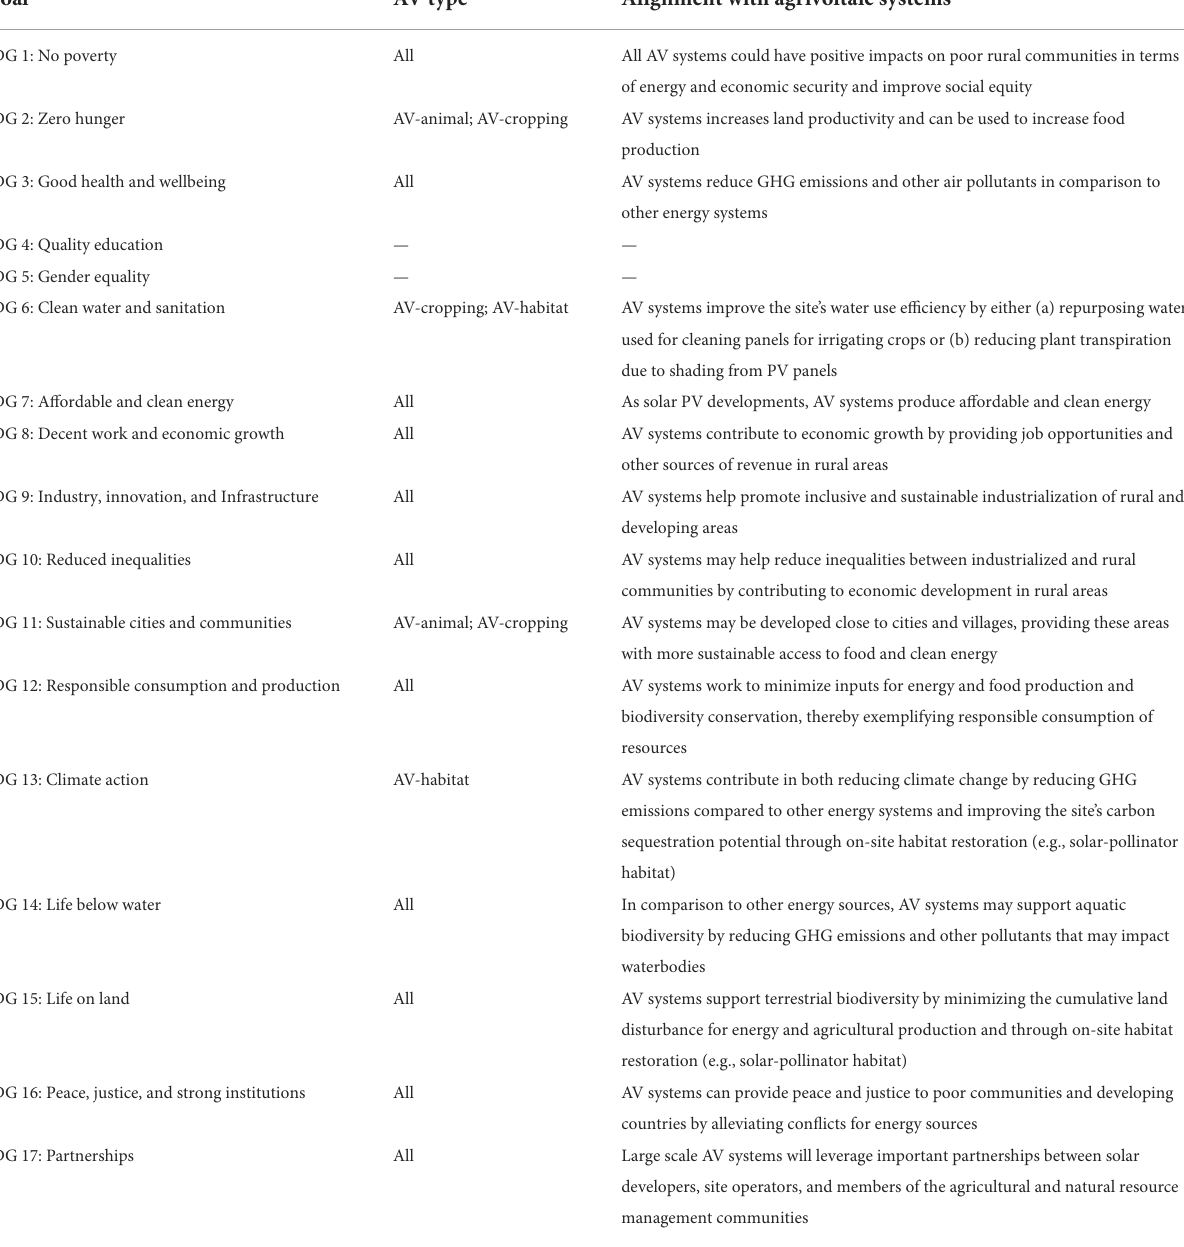
TABLE 2 Alignment of agrivoltaic systems toward the United Nations Sustainable Development Goals. Goal AV type a Alignment with agrivoltaic